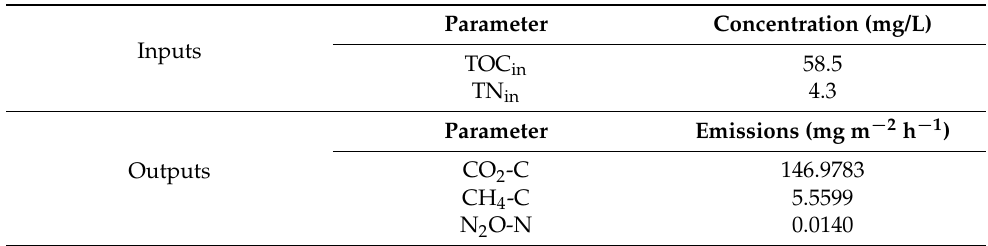
Table 2. Inputs and outputs of the operational